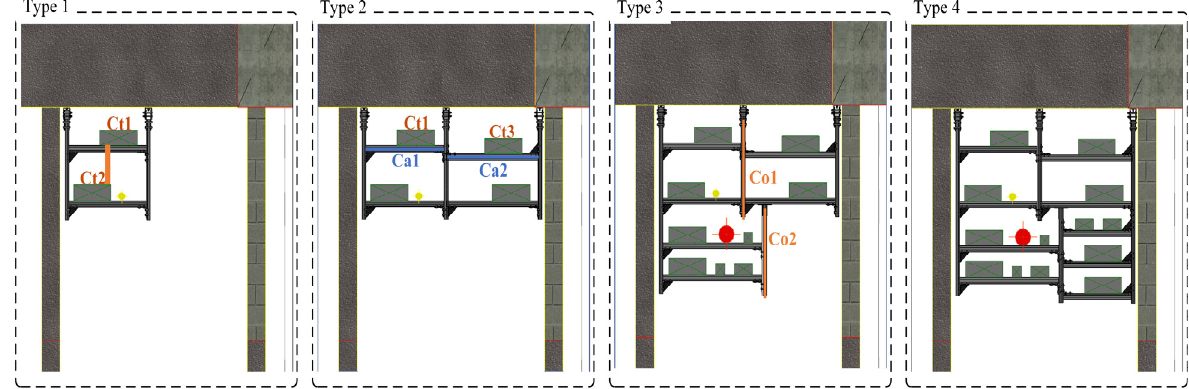
Figure 3. Schematic diagram of the four modeling types in the section view.